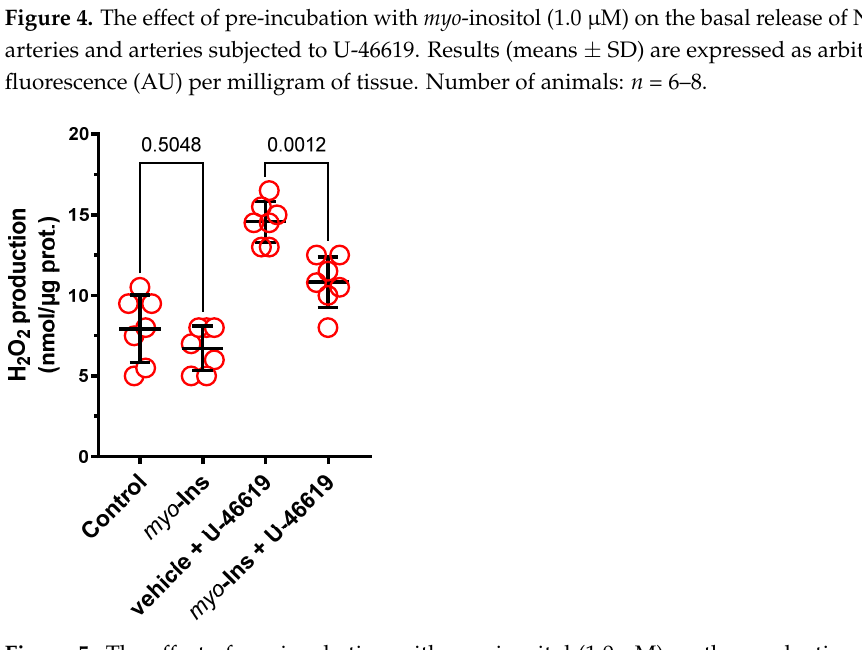
Figure 5. The effect of pre-incubation with myo -inositol (1.0 μ M) on the production of hydrogen peroxide (H 2 O 2 ) in control arteries and arteries subjected to U-46619. Results (means ± SD) are ex- pressed as nanomoles of H 2 O 2 per microgram of protein. Number of animals: n = 6–8.